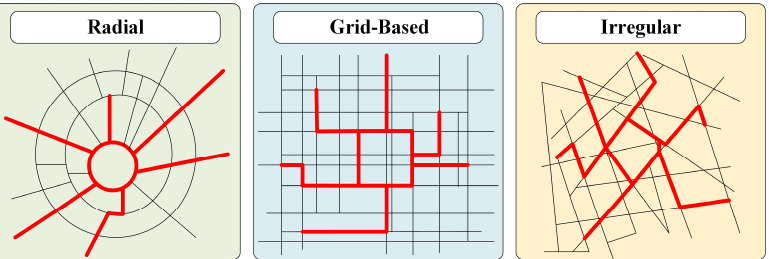
Figure 10. Designation of the radial structure-based geometric model in the case of different urban structures.